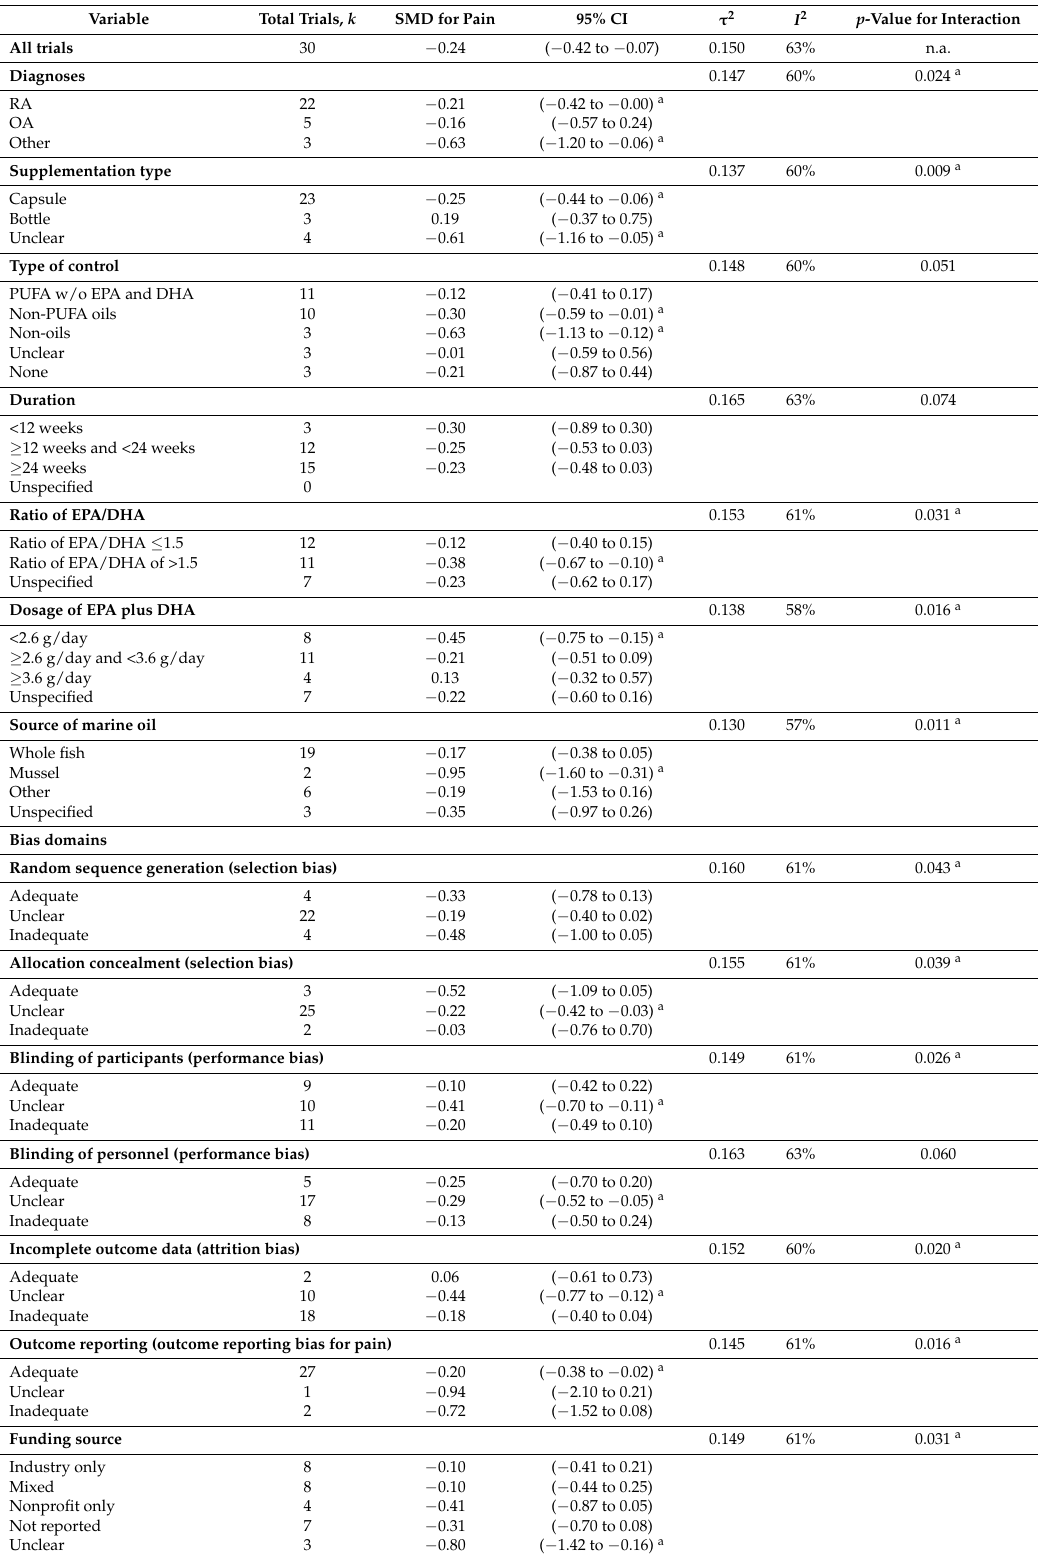
Table 2. Results of meta-regression analyses. Analyzed using a random-effects restricted maximum of likelihood (REML)-based meta-regression